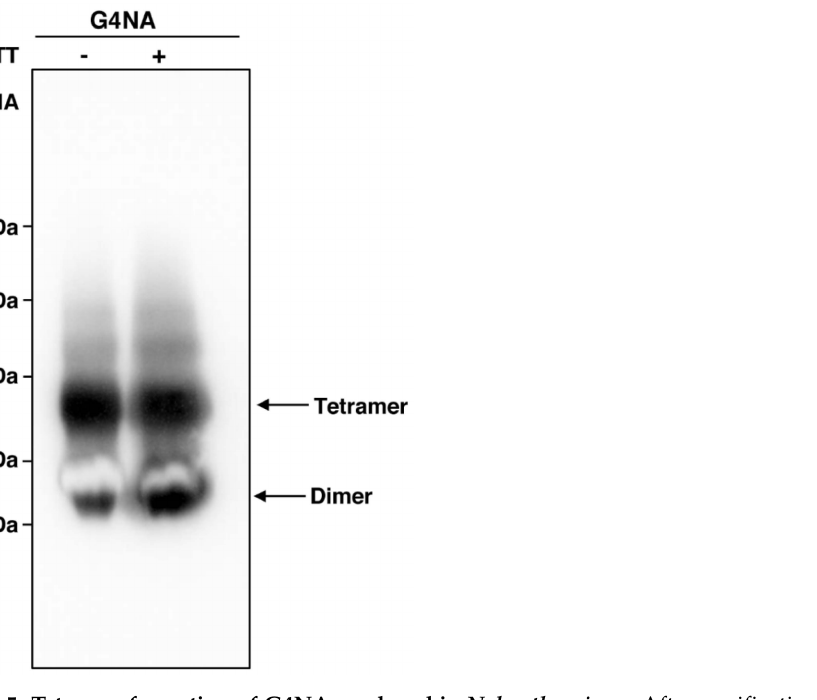
Figure 5. Tetramer formation of G4NA produced in N. benthamiana. After purification of G4NA in the absence ( − ) or presence (+) of DTT from the leaves of N. benthamiana , the purified G4NA was subject to BN-PAGE, followed by Western blotting with anti-HA